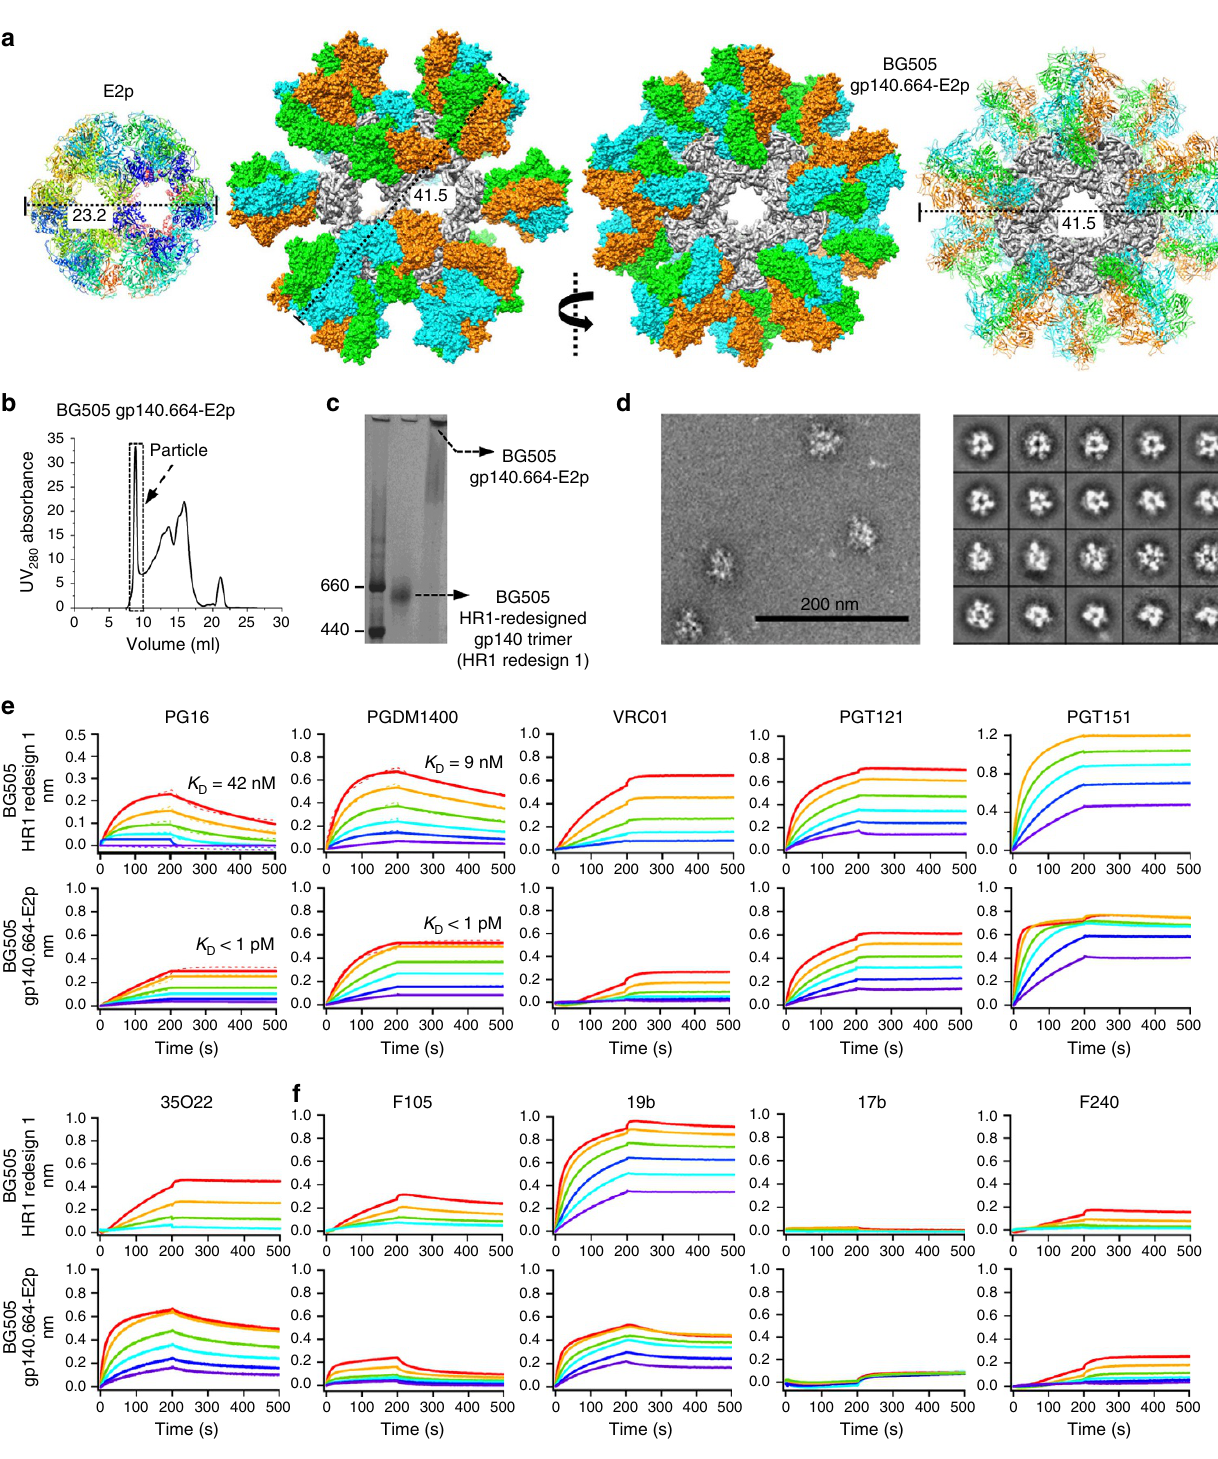
Figure 6 | Design and characterization of 60-meric gp140-E2p nanoparticle. ( a ) Structural models of E2p and gp140.664-E2p nanoparticle. The ribbon model of E2p is colour-coded by protein chains (left). The surface model of gp140.664-E2p is presented in two different views, with the second review centred around a fivefold axis (middle), for which the gp140 trimers are also depicted as ribbons (right). E2p and three gp140 chains within each Env trimer are coloured in grey, cyan, green and orange, respectively. ( b ) SEC profile of gp140.664-E2p from a Superose 6 10/300 GL column. Fractions used for EM and antigenic analyses (8.0–10.0ml) are indicated with a dashed box. ( c ) BN-PAGE of HR1-redesigned gp140 trimer and gp140.664-E2p nanoparticle. ( d ) Micrograph (left) and 2D class averages (right) of gp140.664-E2p derived from negative-stain EM. Octet binding of HR1-redesigned gp140 trimer and gp140.664-E2p nanoparticle to a panel of ( e ) bNAbs and ( f ) non-NAbs, with additional antibody binding data shown in Supplementary Fig. 6. Sensorgrams were obtained from an Octet RED96 instrument using a titration series of six starting at a maximum of 16nM for gp140.664-E2p. K D values are calculated from 1:1 global fitting for apex-directed bNAbs PG16 and PGDM1400 in e